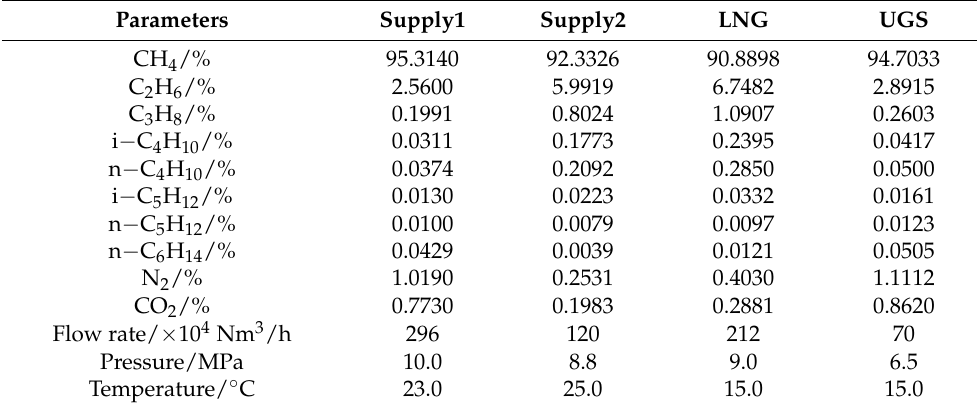
Table 1. Parameters of gas